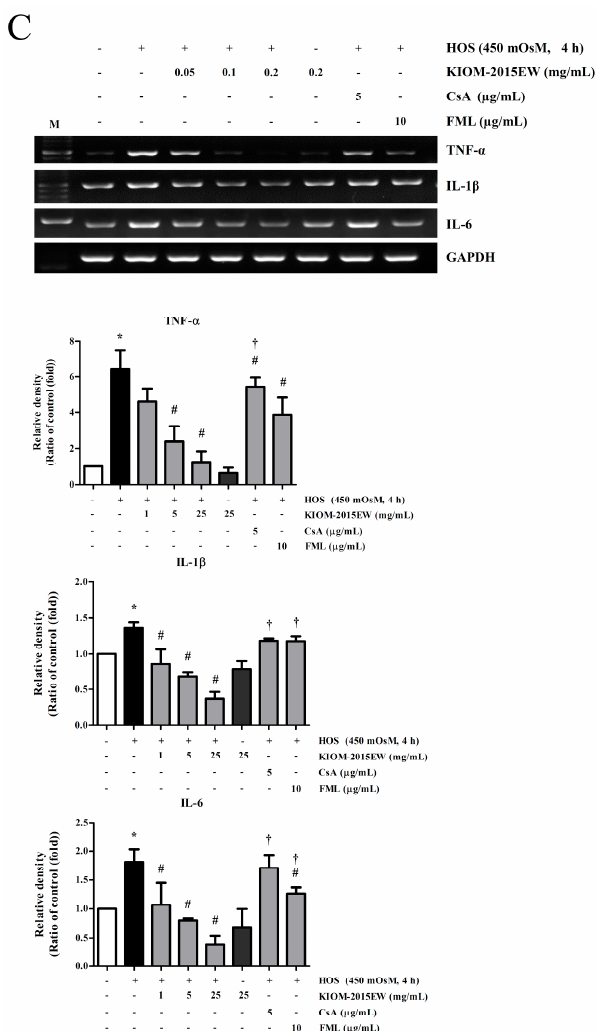
Figure 2. The anti-inflammatory effect of KIOM-2015EW on proinflammatory cytokines (tumor necrosis factor (TNF)- α , interleukin (IL)-1 β and IL-6) in HOS-induced HCECs. HCECs were cultured in isomer (312 mOsM) medium, switched to hyperosmotic medium (450 mOsM) alone or in the presence of different concentrations of KIOM-2015EW for 24 h, and protein levels were estimated by enzyme-linked immunosorbent assay (ELISA) ( A ); and immunofluorescence staining (IF) ( B ); or 4 h to evaluate mRNA level by reverse transcription-polymerase chain reaction (RT-PCR) ( C ). CsA and FML were used as positive anti-inflammatory drugs. Data are summarized as mean ± SD from three independent experiments. HOS, hyperosmolar stress; CsA, cyclosporine A; FML, fluoremetholone. * p < 0.05 vs. control, # p < 0.05 vs. HOS, † p < 0.05 vs. KIOM-2015EW (25 µ g/mL). The full size blot is shown in Supplementary Figure S1.